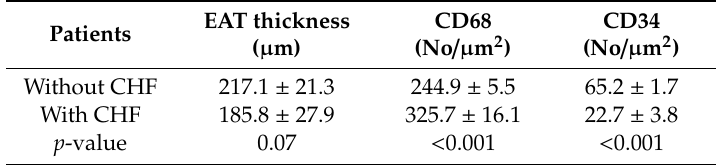
Table 2. Mean EAT thickness and IHC markers of macrophages accumulation and angiogenesis in peri-atrial EAT samples from CAD patients.